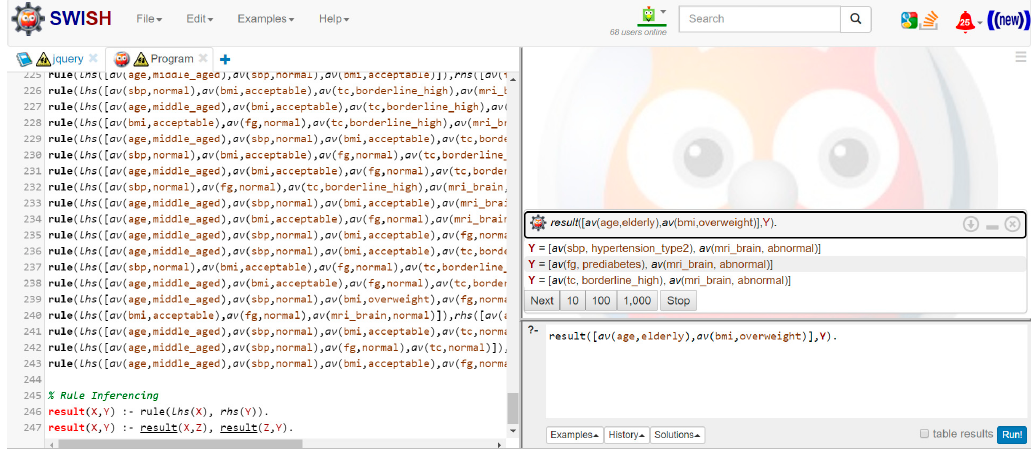
Figure 7. Example of rule inference through PROLOG. Table 10. Example of a conclusion obtained from rule inferencing: hypothetical syllogism.